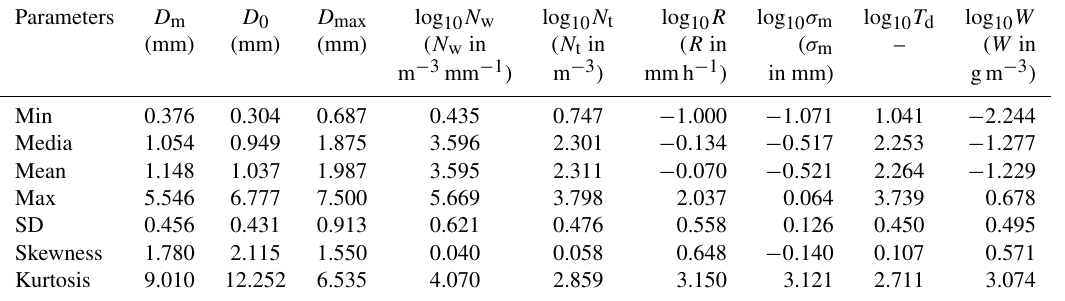
Table 1. Statistics of DSD parameters for all observations: D m , D 0 , D max , log 10 N w , log 10 N t , log 10 R , log 10 σ m , log 10 T d and log 10 W .